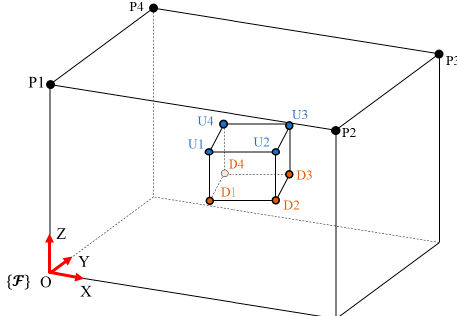
Figure 4. Cable-driven parallel robot scheme and the points for cable connections between the inertial frame and the end effector. Table 1. Connection points for cables R = 2.